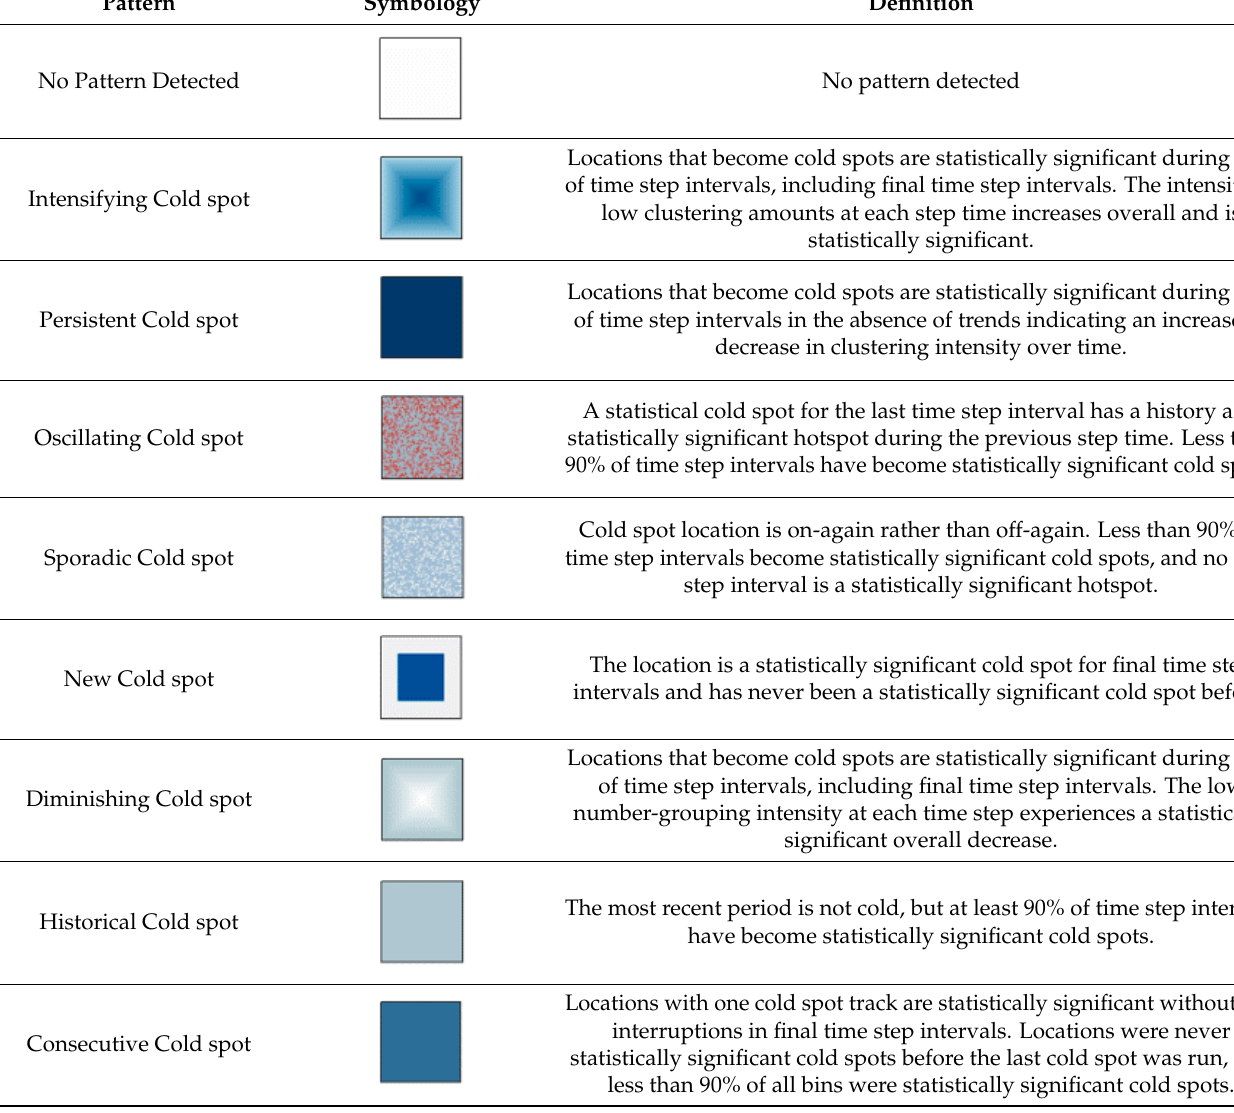
Table A2. Cold spot categories based on [44].